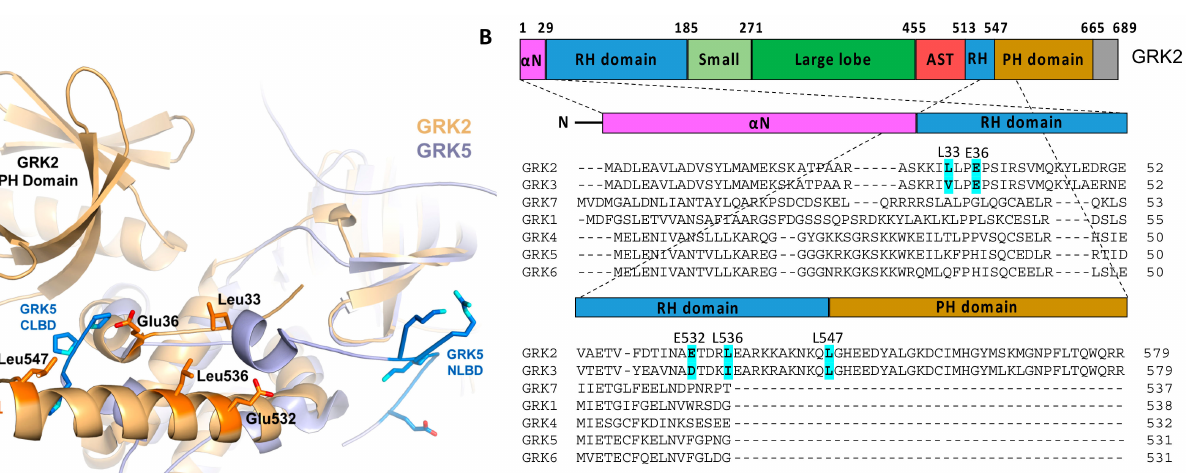
Figure 3. Hypothetical GPCR-interacting sites in the GRK2 RH domain. ( A ) GRK2 (PDB: 4PNK [72], gold) aligned with full-length GRK5 (PDB: 4TND [73], slate) indicated the presence of a patch of solvent-exposed residues uniquely conserved in GRK2/3 and similarly disposed with respect to the membrane as the NLBD and CLBD of GRK5. These residues could conceivably interact with activated GPCRs [49]. Side chains of the GRK2 residues that were modified in this study are depicted as orange sticks. ( B ) Domain diagram of GRK2 and the structure-based sequence alignment of the seven human GRKs, with the targeted positions in GRK2 highlighted.